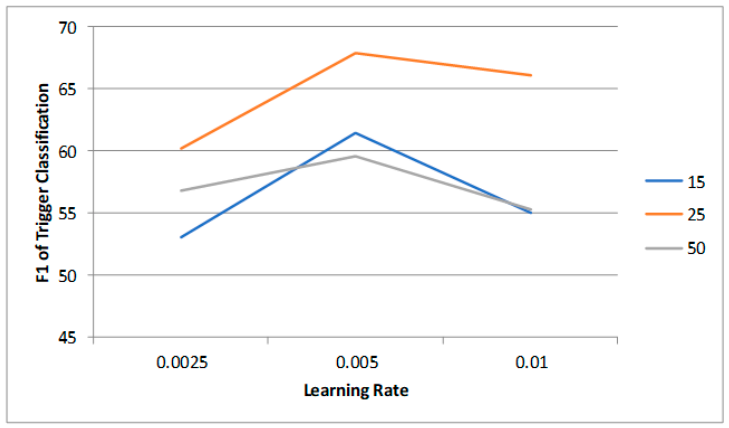
Figure 6. The influence of learning rate and batch size on trigger classification.